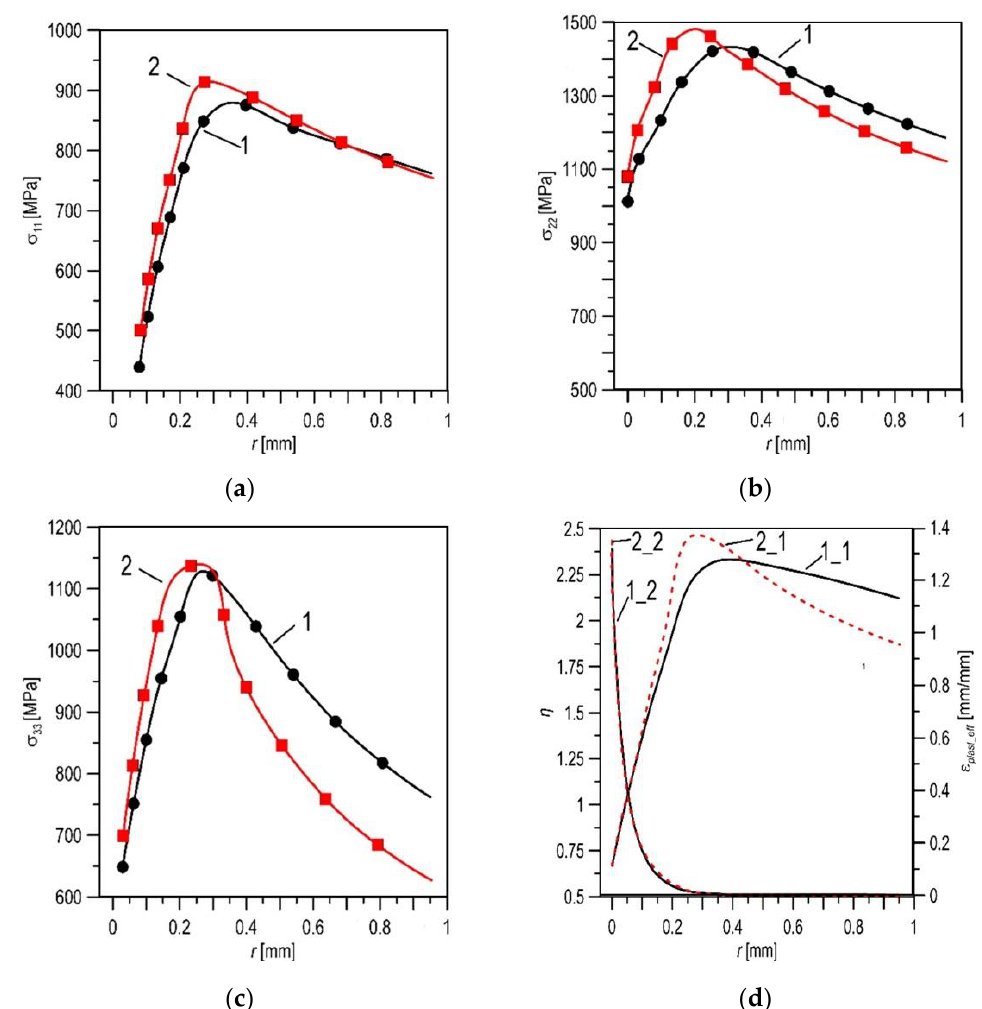
Figure 9. The distributions of stress components ( a – c ) of strain e pl_eff and coefficient of triaxiality stress η ( d ) at load at Du = 1.2 mm: ( a – c )—for the X52 steel in the as-received state, denoted as 1; and after 30 years of service, 2; ( d )—for η (1_1), (2_1) and for e pl_eff (1_2), (2_2), where σ 11 —stress in direction of crack growth, σ 22 —stress in the direction perpendicular to the crack plane, σ 33 —stress in the direction of the specimen thickness, r —distance from the crack